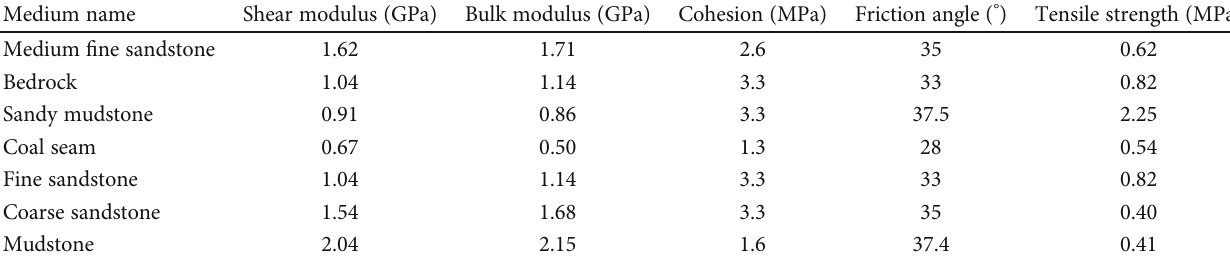
Table 1: Mechanical parameters of coal – rock.